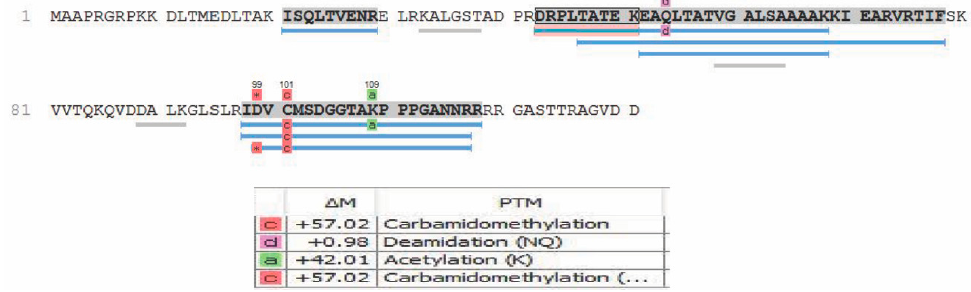
Figure 4. Example of post-translational modifications (PTMs) detected via PEAKS DB analysis for